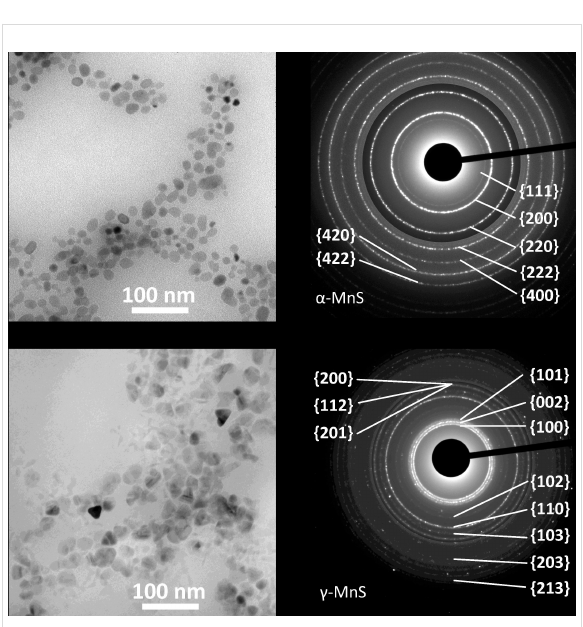
Figure 5: TEM images (left) and electron diffraction patterns (right) of NCs obtained by high temperature decomposition of Mn 2 (CO) 10 with S/Mn = 2. (a) α -MnS NCs synthesized using HdAm (L/Mn = 4); (b) γ -MnS NCs synthesized using a mixture of StAc (L acid /Mn = 2:1) and HdAm (L amine /Mn = 4). The contrast of the outer part of both diffraction patterns was digitally increased to show the high index-